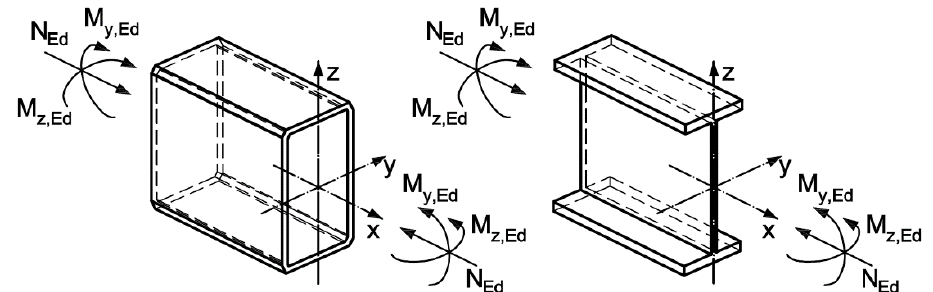
Figure 1. Definition of the internal forces and cross-sectional axes of the members.